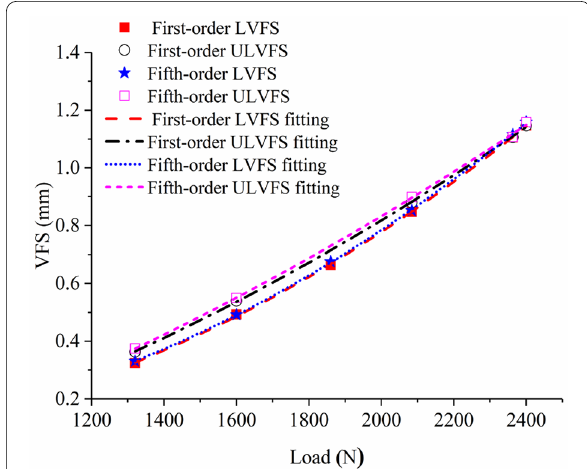
Figure 10 Vertical feature size during loading (LVFS) and unloading (ULVFS) versus